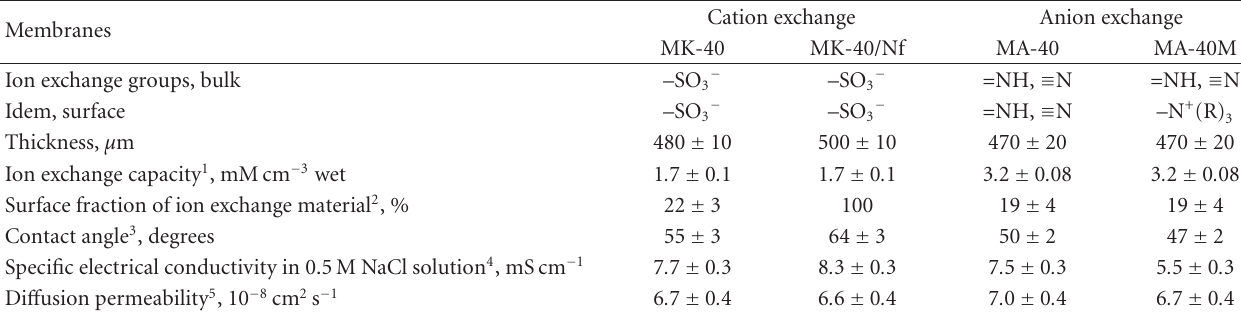
Cation exchange